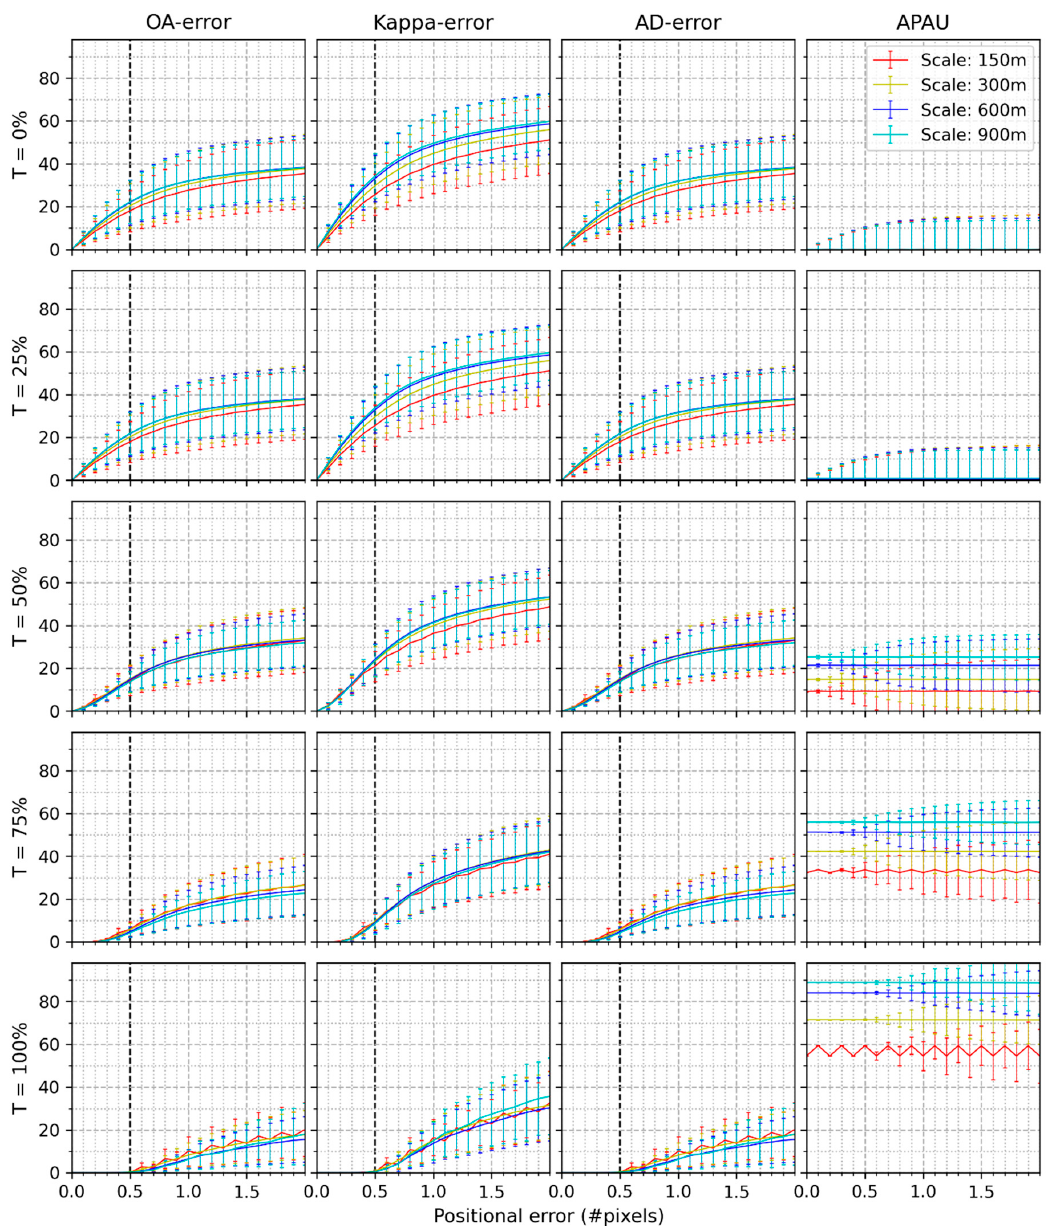
Figure 4. Mean and standard deviation of OA − error , Kappa − error , AD − error , and APAU of the twelve study sites at di ff erent scales when the classification consists of 15 classes.